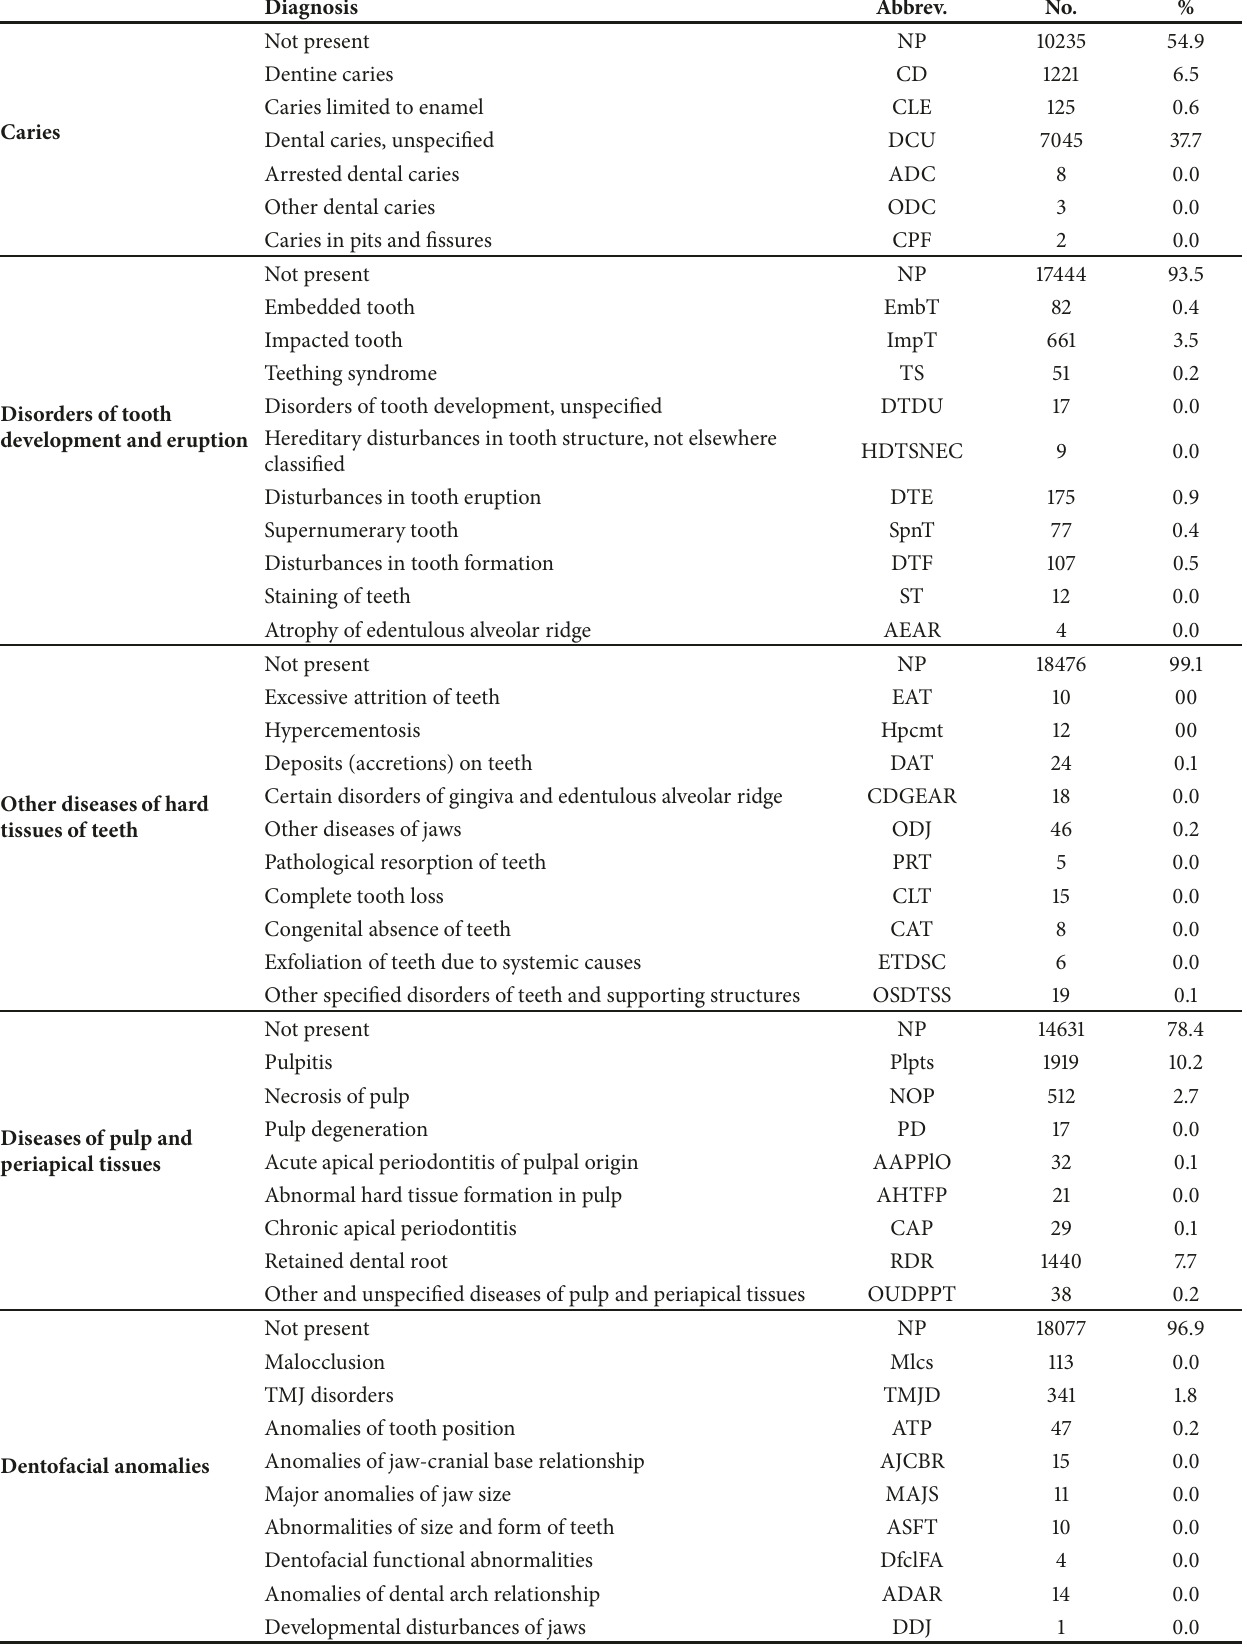
Table 1: Classification and distribution of oral lesions (hard